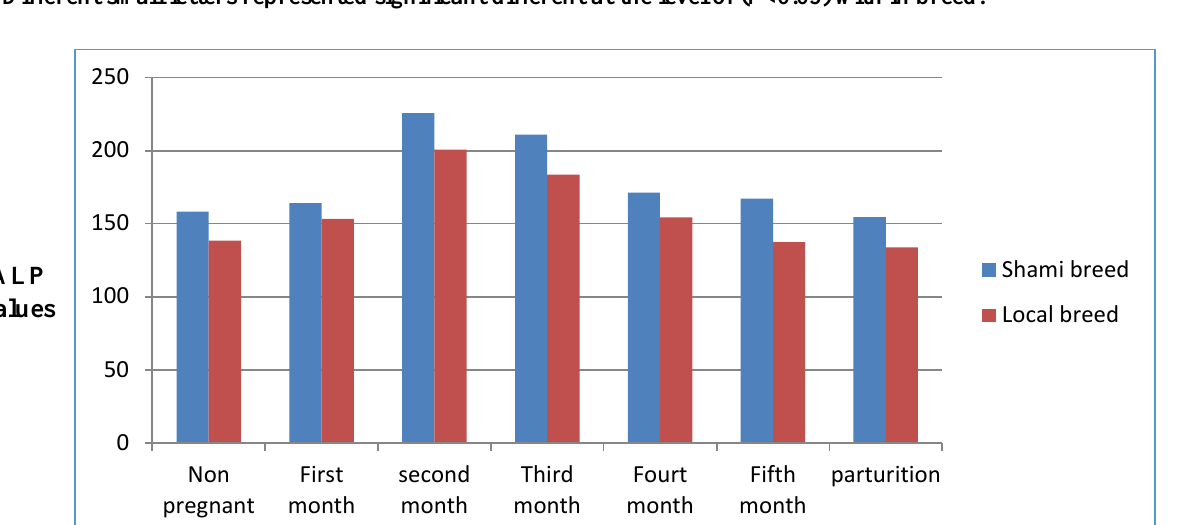
Different small letters represented significant different at the level of (P<0.05) with in breed.